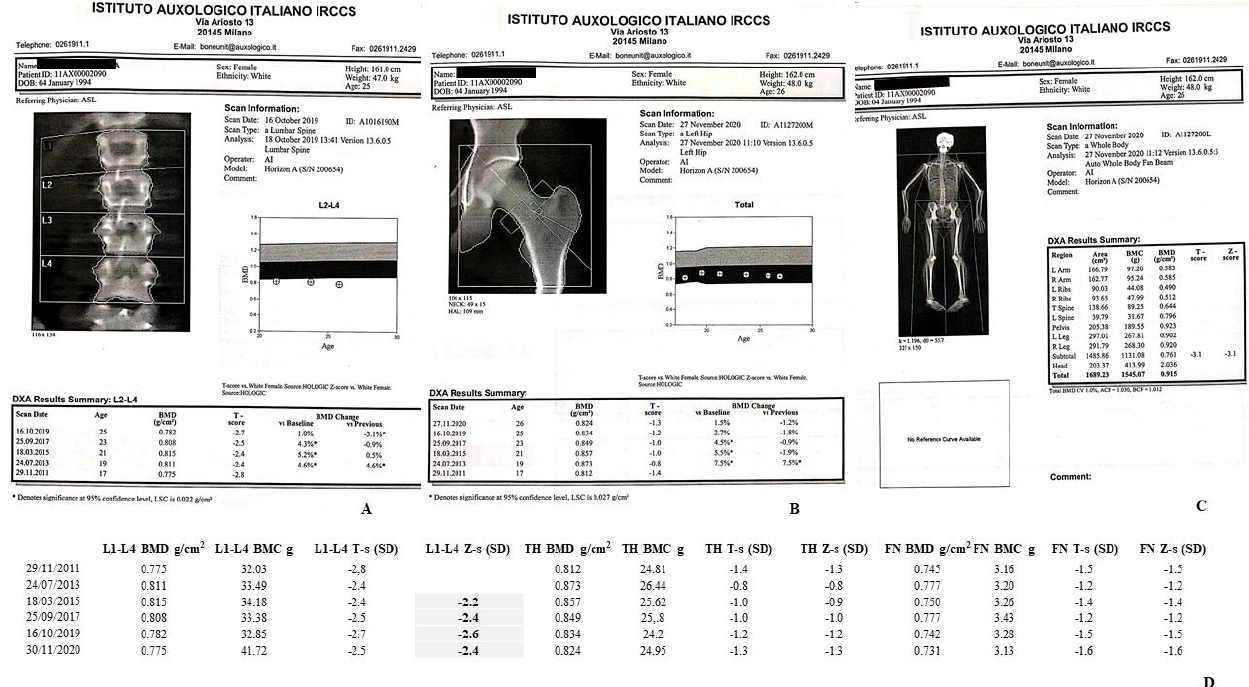
Figure 3. ( A – D ). II-1 Tw1 LS- (A), TH/FN- ( B ), and T. B.-DXA ( C ) scans. A e B report also the previous relative findings, from 2011 to 2019, showing the trend of BMD over the years. Asterisk refer to values that are significantly different from the previous ones (result calculated directly by the software of the device). ( D ) II-1 Tw1. It reports also LS, TH and FN Z-score. In bold are shown the Z-scores (LS) which, in accordance with ISCD, diagnosed the reduced bone mass compared.